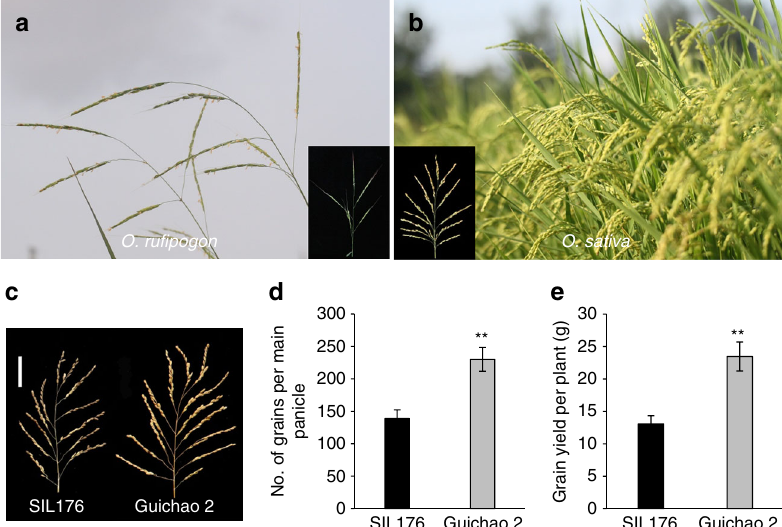
Fig. 1 Comparison of a phenotype. a , b The transition of grain number from wild rice ( Oryza ru fi pogon ) to cultivated rice ( Oryza sativa ). A panicle is shown in the lower corner, respectively. c The main panicle of SIL176 and Guichao 2. Scale bars, 5 cm. d , e Comparison of the number of grains per main panicle and grain yield per plant between SIL176 and Guichao 2. Data are means, with error bars showing the standard error of mean (SEM), n = 30 (two-tailed Student ’ s t test; ** P <